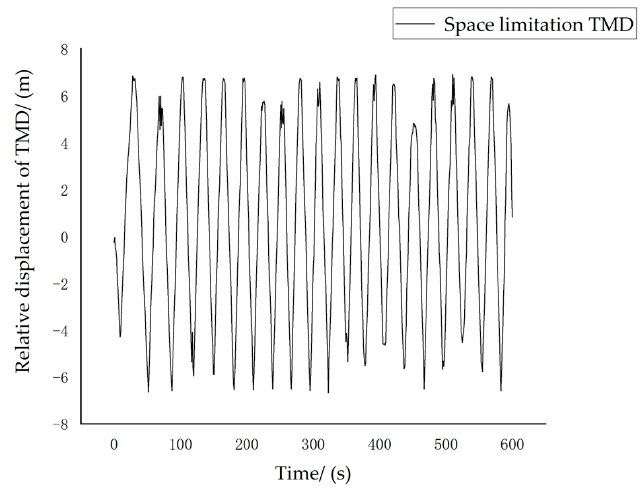
Figure 13. Relative displacement of stroke-limited TMD.